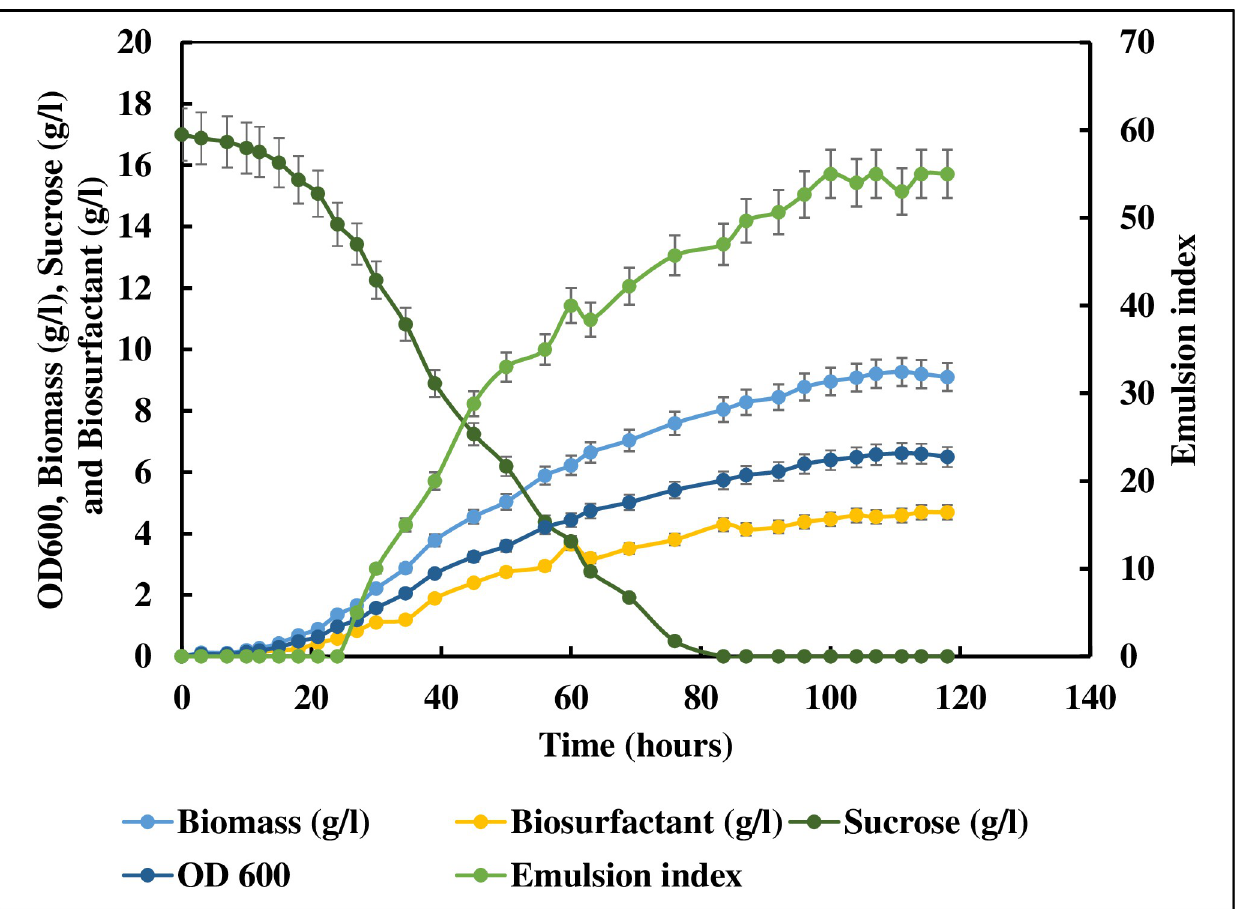
Fig 5. Biosurfactant production in a 5 L